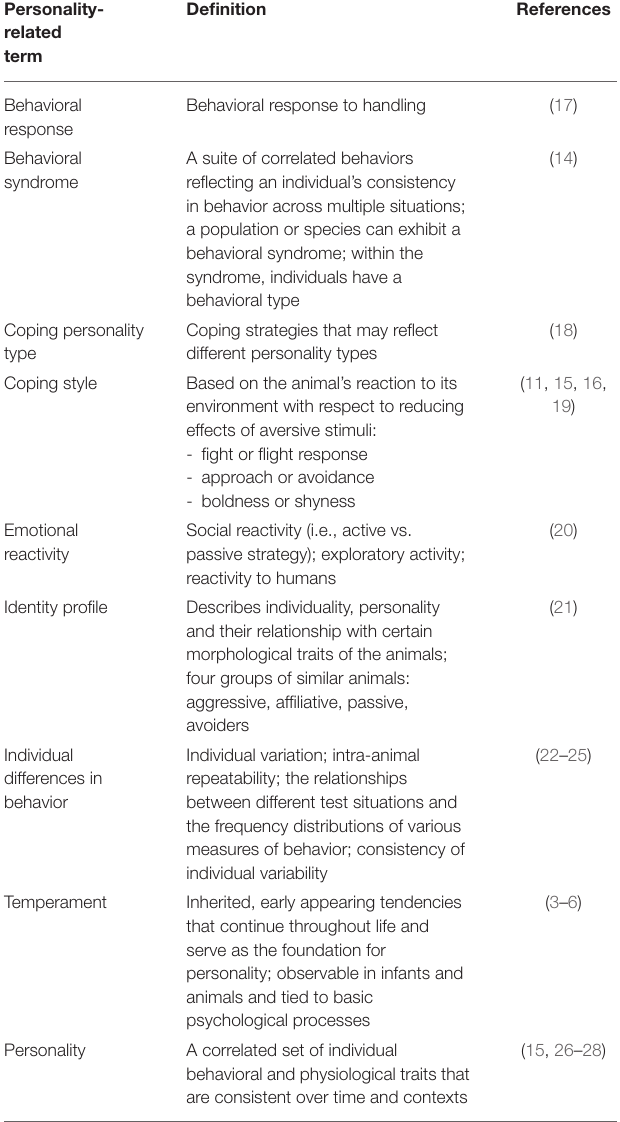
TABLE 1 | Different personality-related terms in alphabetical order used to describe individual differences in animal behavior and their definitions. Personality- related